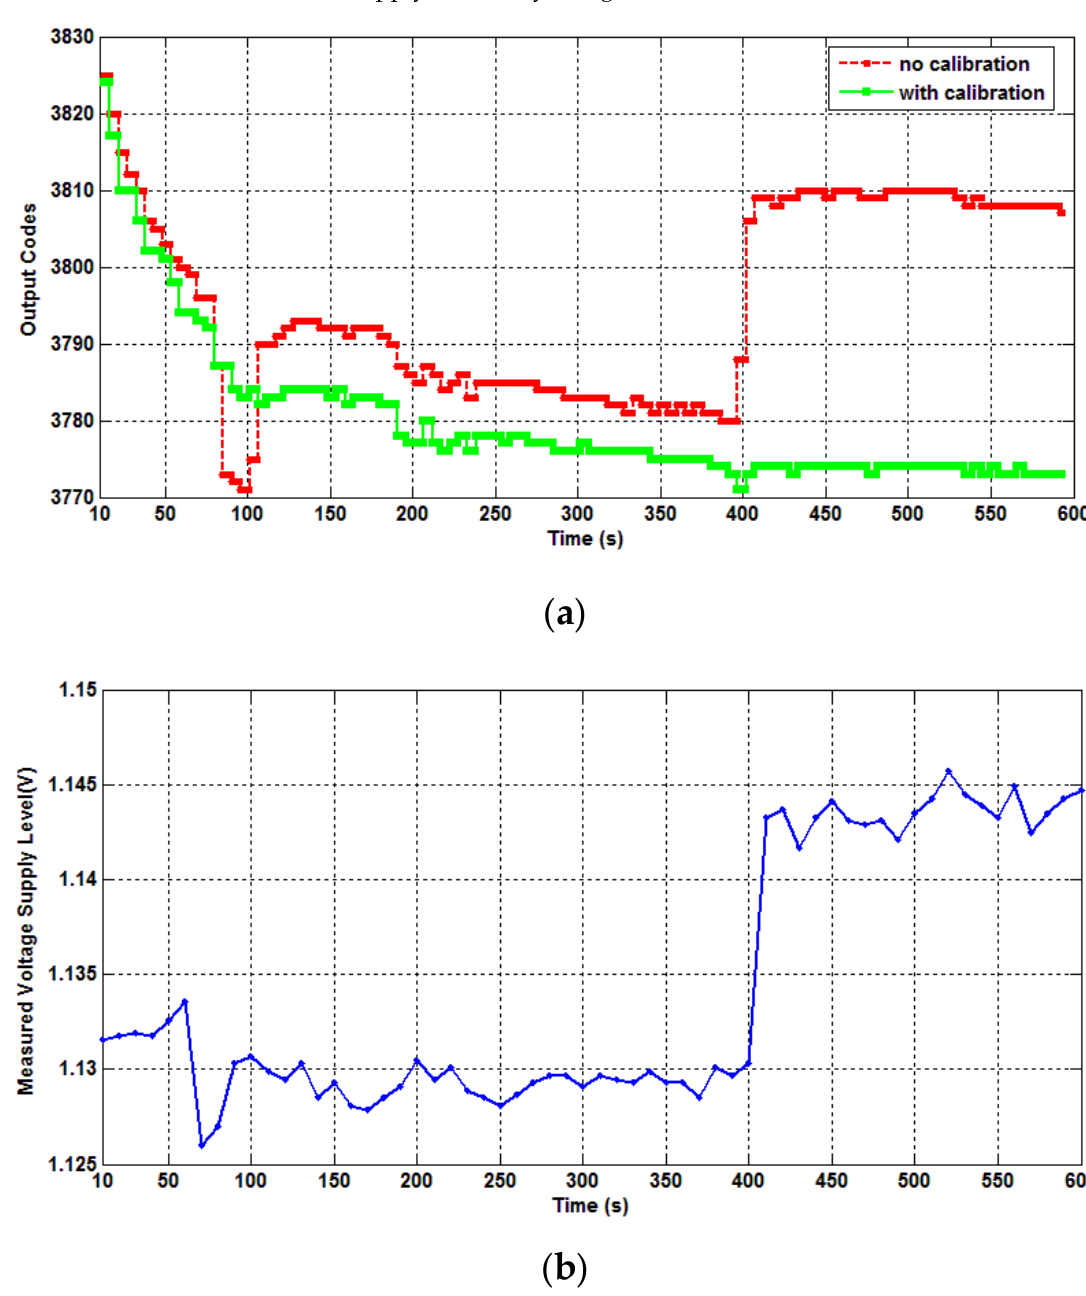
Figure 19. The sudden output code change at around 400 s (the red line “no calibration” in ( a )), incurred by the voltage supply level change ( b ), measured on a Cyclone IV FPGA development board in [109].The sudden change in the output codes in ( a ) can be mistaken for a dynamic temper- ature change of − 26 °C within 0.7 s. The green line shown in ( a ) is obtained using a calibration method that partially removes the voltage supply sensitivity.